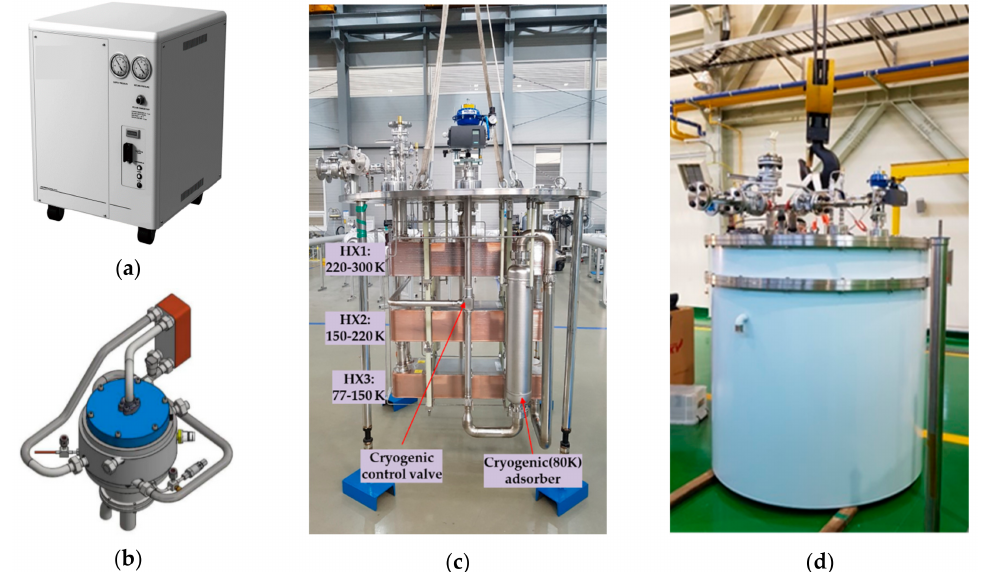
Figure 2. Pictorial depiction of the main components of the reverse Brayton cryogenic system: ( a ) scroll